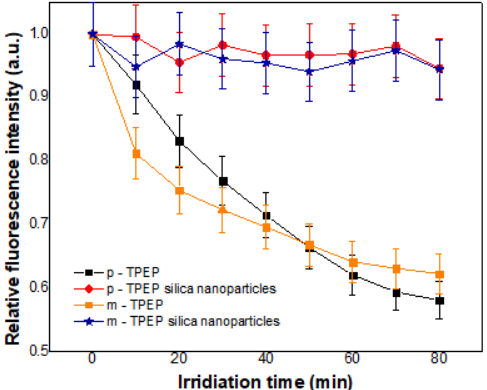
Figure 7. Irradiation time dependent photobleaching behaviors of silica nanoparticles versus free dye of pTPEP and mTPEP under Xe lamp (150 W).